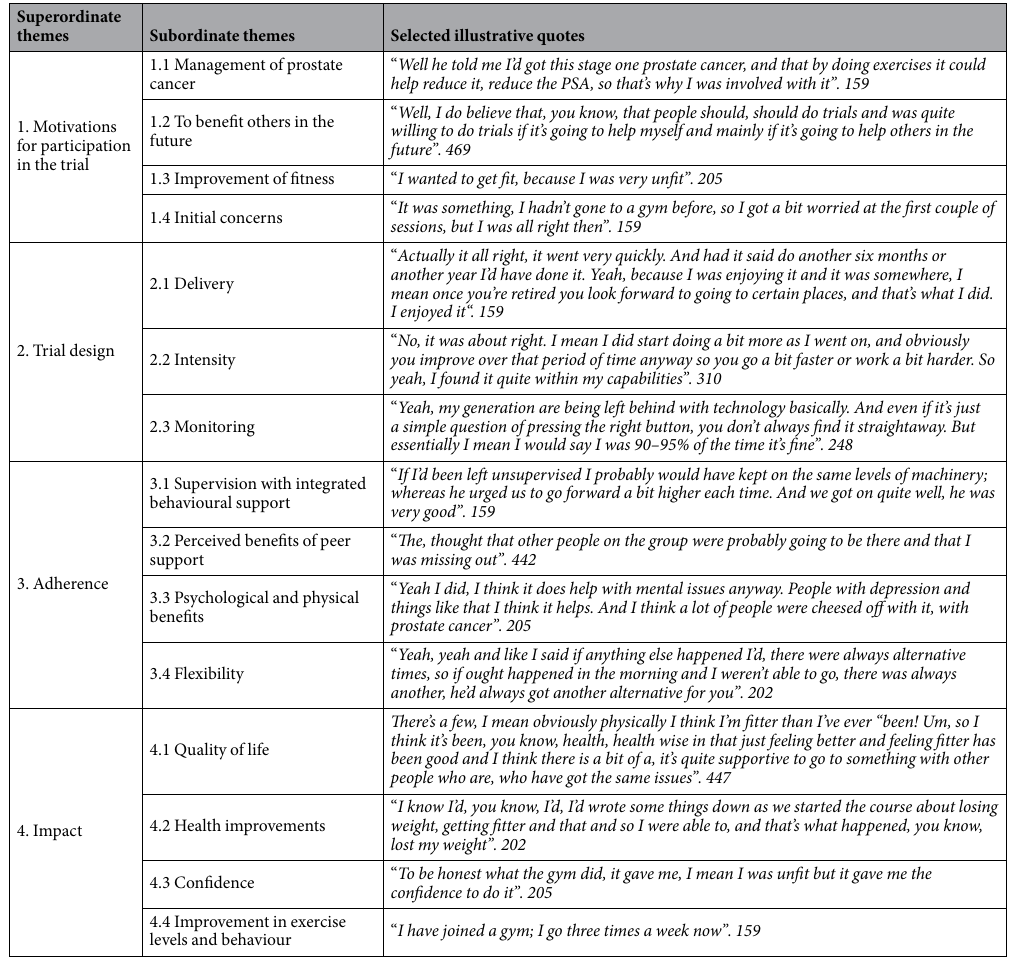
Table 4. PANTERA qualitative feedback organised into superordinate and subordinate themes will illustrative